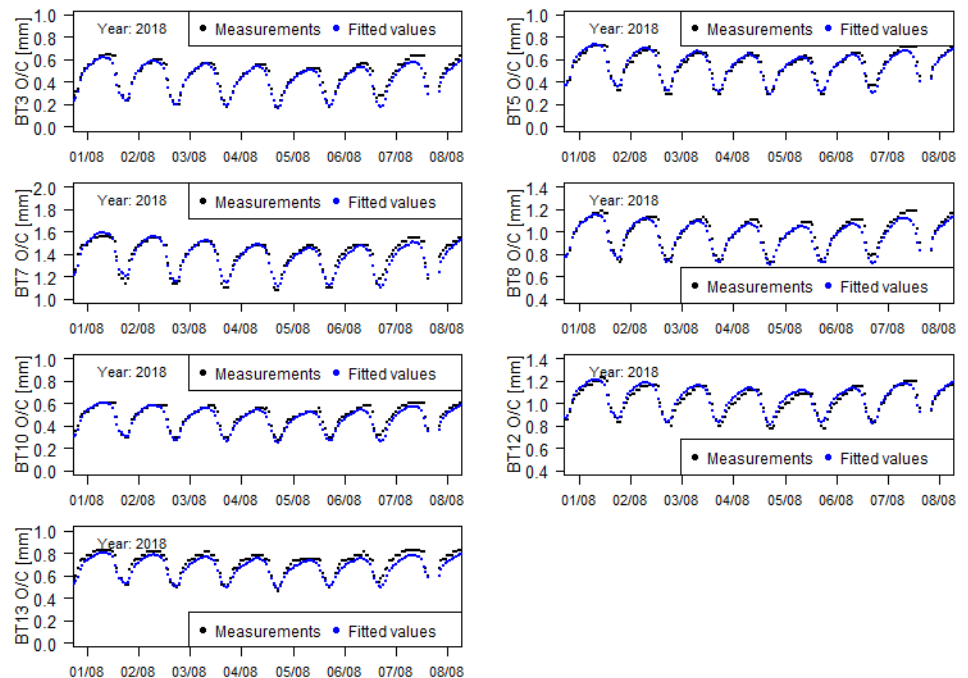
Figure 13. Time series of the relative movements between block measurements and fitted values between the 1st and the 8th of August